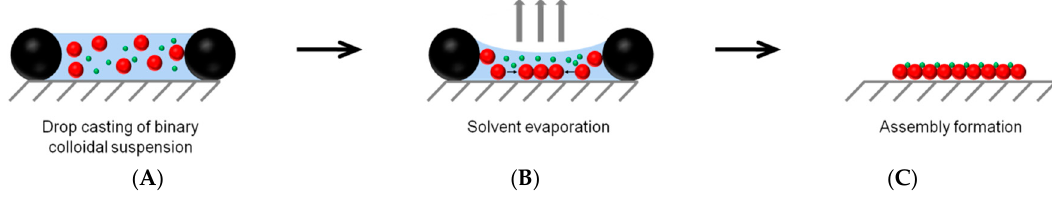
Figure 1. Schematic representation of the assembly process to generate binary colloidal crystals. ( A ) A binary colloidal suspension is drop-cast onto a Si-wafer where the accessible surface area is enclosed by a rubber O-ring; ( B ) Upon evaporation of the suspending media the particles form a uniform arrangement resulting in ( C ) the formation of a binary colloidal crystal.